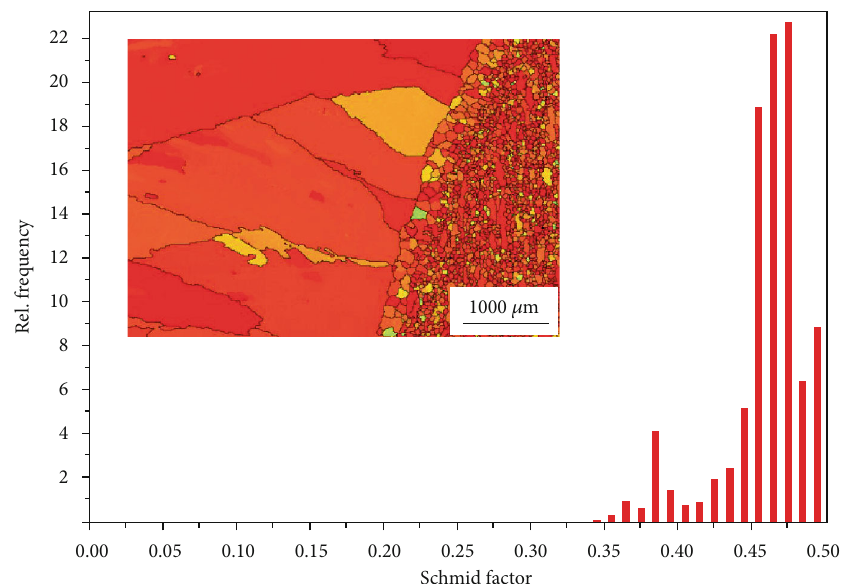
Figure 5: The Schmid factor distribution of grains in each zone of the 3A21/7075 cladding material.